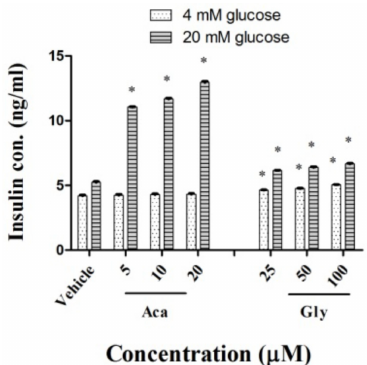
Figure 2. Effects of acankoreagenin on glucose stimulated insulin secretion. RIN-m5F cells were either cultured in basal (4 mM) or stimulated (20 mM) glucose concentrations in the presence of samples. * p < 0.05 versus vehicle-treated control. Bars indicate SEM ( n = 3). Gly, glybunide; Aca, acankoreagenin.